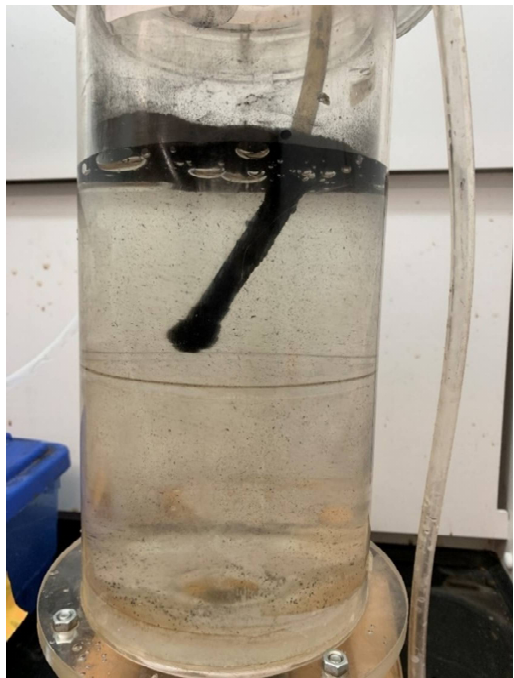
Figure A2. The visualization of the floating biochar powder layer that keeps the air bubbles from being released from DI water into the headspace. Table A1. The average changes ( ∆ ) in manure properties from ‘before’ and ‘after’ 3-h manure agitation. A negative ∆ value indicates a decrease, and a positive value indicates an increase. Moisture, mineral matter, and targeted chemicals are in units of g/L. A negative % Diff indicates manure properties of ∆ Treatment were % Diff less than the manure properties of ∆ Control; a positive %Diff indicates otherwise. The bold font states statistical significance.